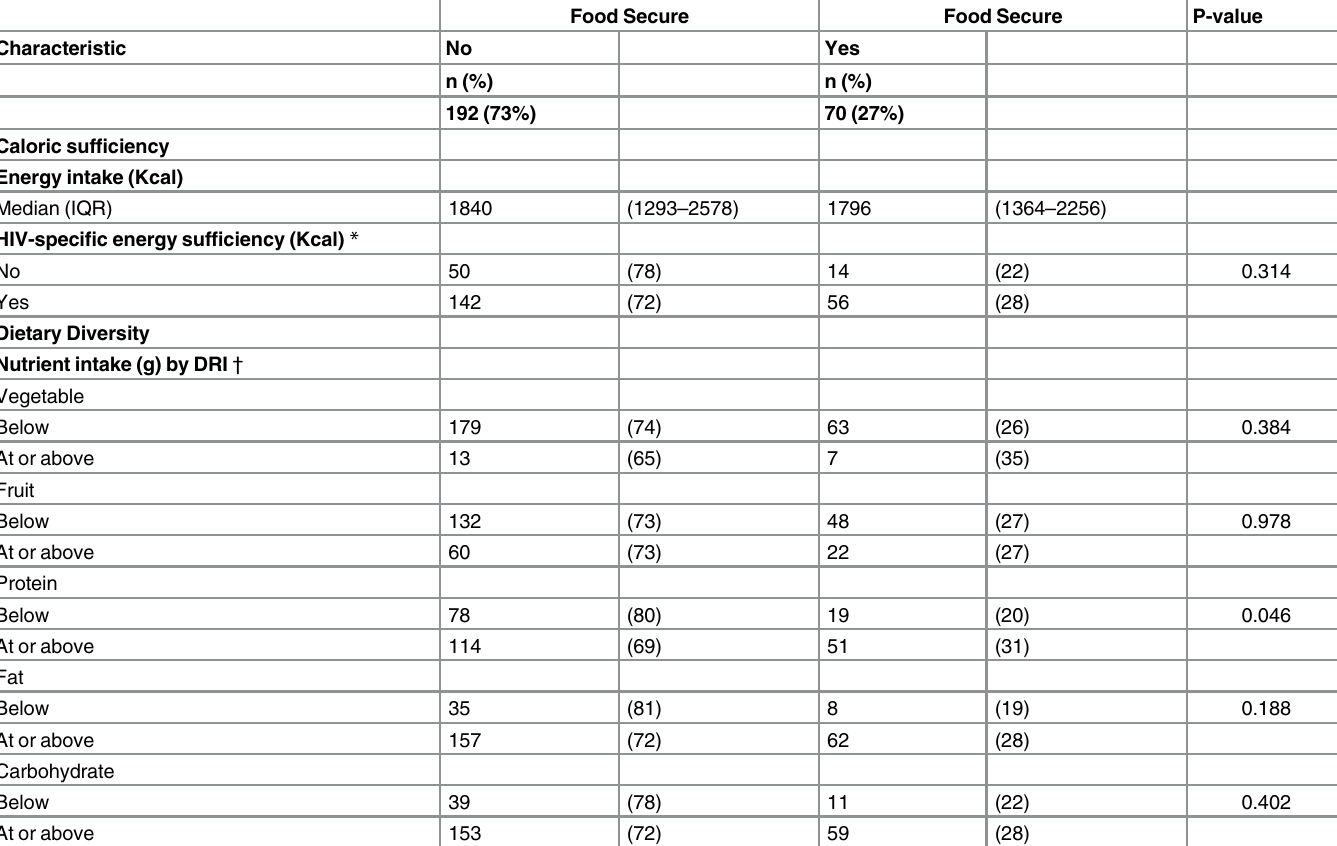
Table 3. Bivariate comparison of daily participant caloric and nutrient sufficiency by food security status (n =